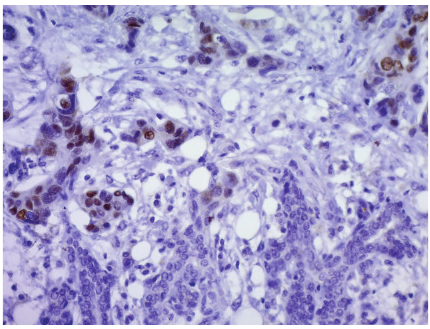
Figure 3: Parotid: immunostain with anti-estrogen receptors anti- body × 40: the nuclei of the malignant cell are highlighted in brown. Parotid ducts are seen in the lower part of the